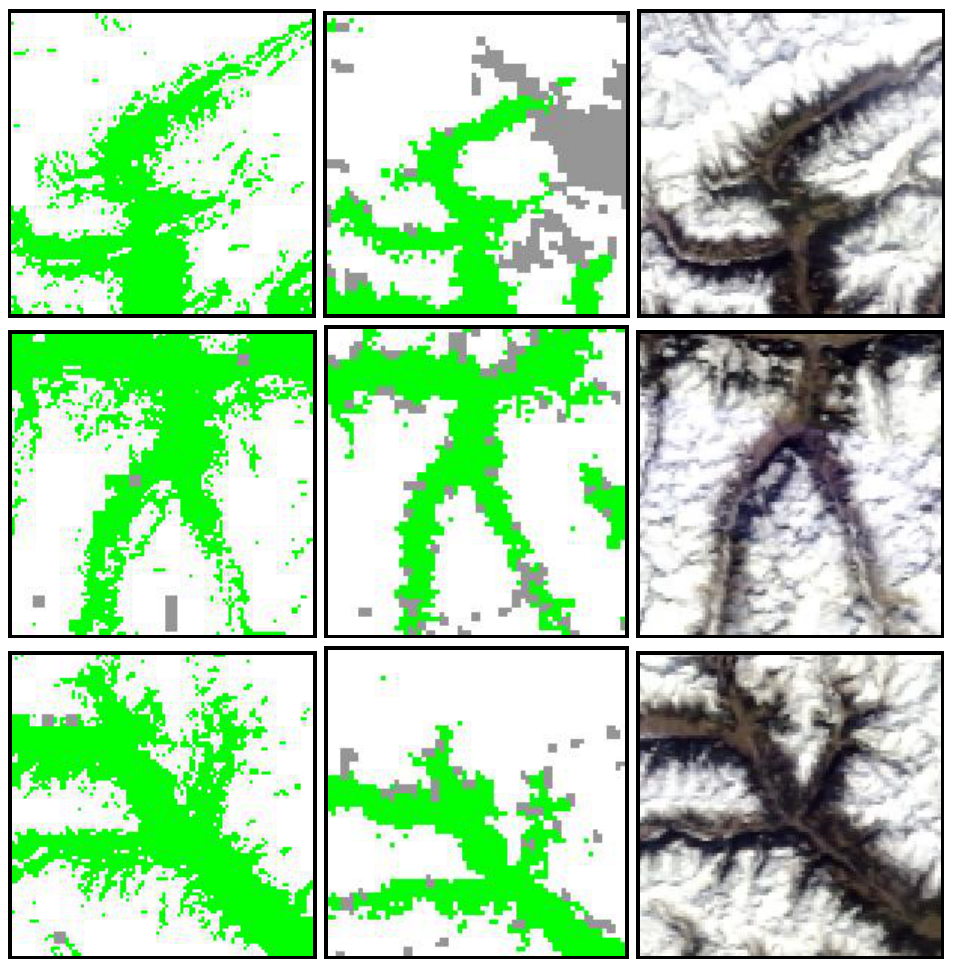
Figure 8. Detailed examples of EURAC SCA maps in comparison to MOD10 images from NASA algorithm and RGB